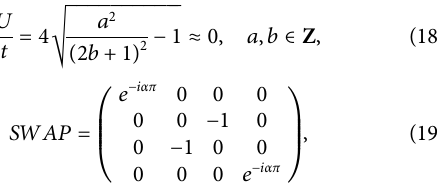
where, | v 〉 i ,0 is the encoded quantum state in the fi rst lattice in Figure 2, which is the state of quantum walk; | v 〉 i ,1 is the quantum state in the second lattice, which is used to assist quantum error correction. Also, the lattice locations of | v 〉 i ,0 and | v 〉 i ,1 are entangled in the model. The quantum state | v 〉 i ,0 has superposition state in the process of quantum walk: